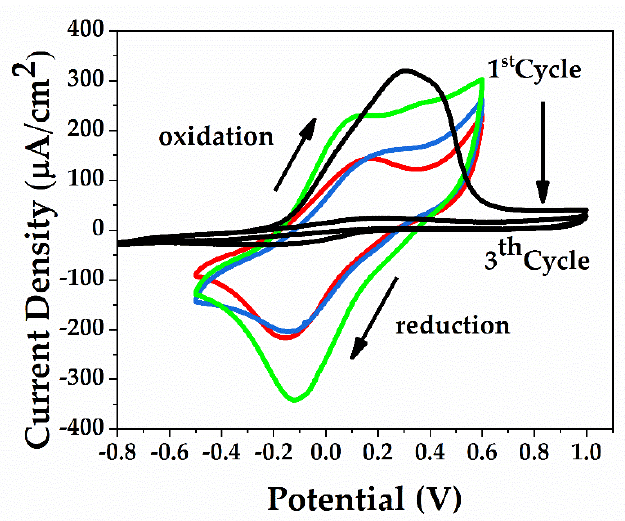
Figure 8. CV curves recorded in phosphate buffer saline PBS (7.00) and 0.1 M KCl of the EP/IDEs with the PANI:PSS/SWCNT/Fc film compared to IDEs with